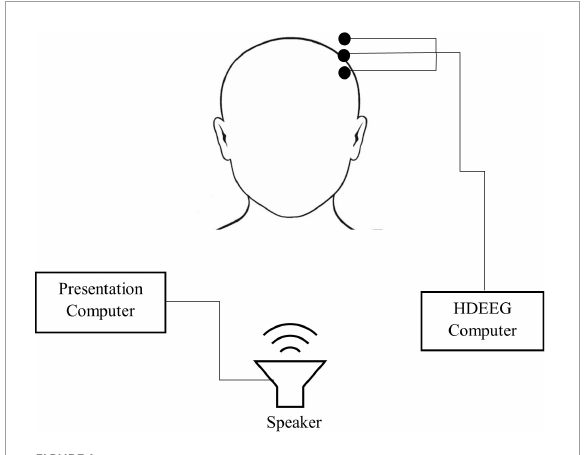
FIGURE1 Schematic diagram of the set up used in both experiment 1 and 2. Testing was conducted in a sound attenuated booth.